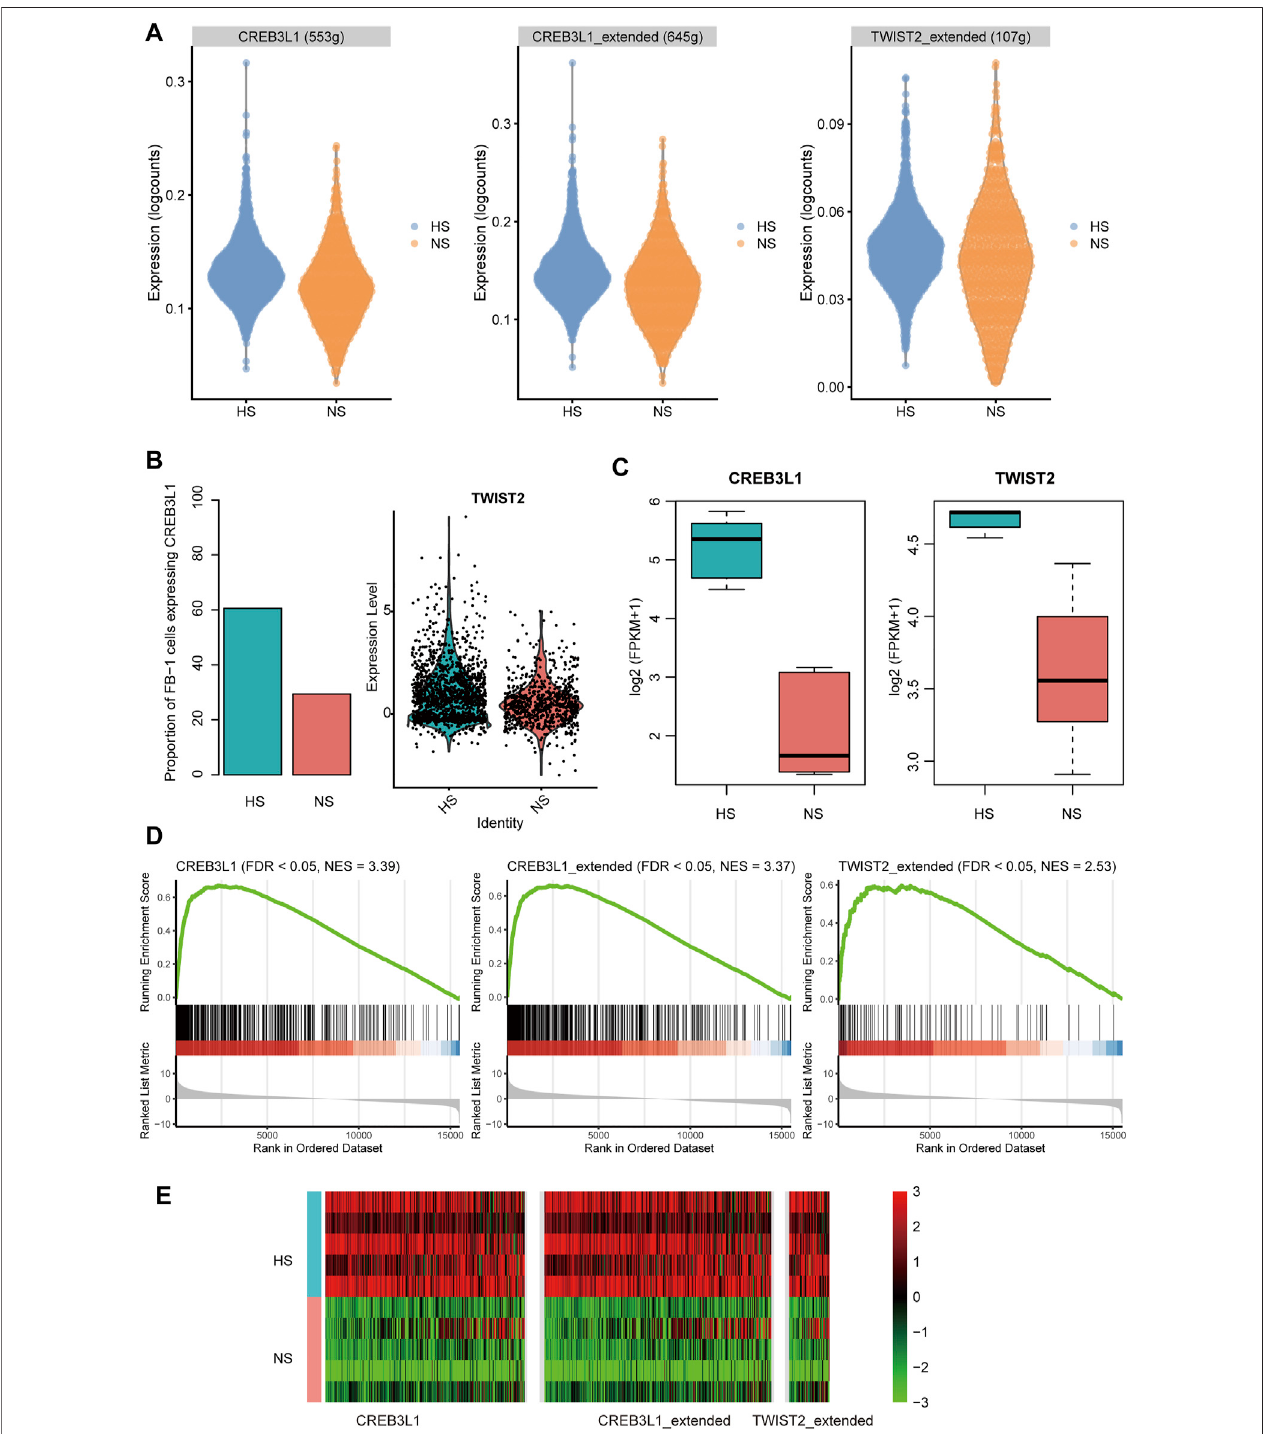
FIGURE7| The transcription factors (TFs) and regulatory networkinvolvedin HS. (A) Thedifferential transcriptional activitiesofthekeyTFs inFB-1 ofHSsamples. (B) The differential proportion of FB-1 cells expressing CREB3L1 and differential expression of TWIST2 between the FB1- cells of HS and NS. (C) The differential expression ofTFs between the bulkRNA-seqsamplesofHS and NS. (D,E) UpregulationofTF target genesin thebulk RNA-seq samplesofHSby geneset enrichment analysis (GSEA).